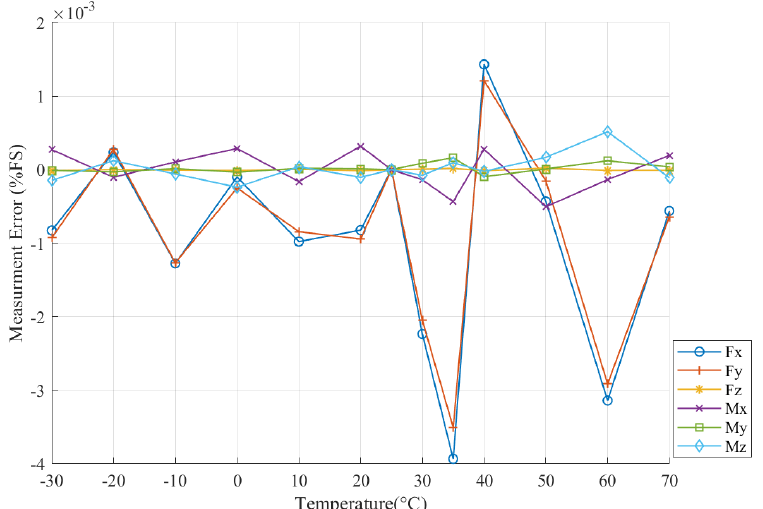
Figure 6. Measurement errors after compensating by